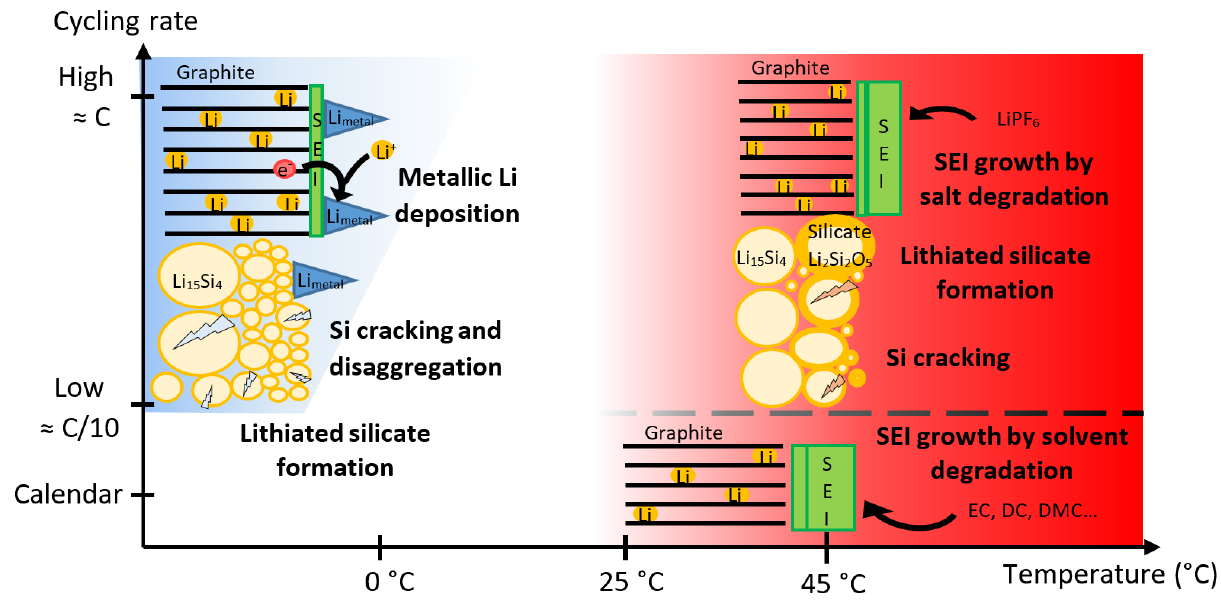
Figure 9. Schematic representation of main aging degradation mechanisms of negative electrode for different aging con- ditions.